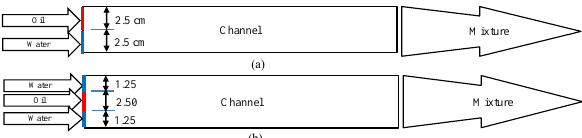
Figure 1: Type of inlet flow (a) The oil inlet above the water, and (b) The oil inlet from the center